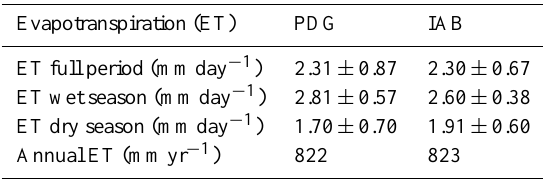
Table 5. Average evapotranspiration for PDG and IAB sites. Evapotranspiration